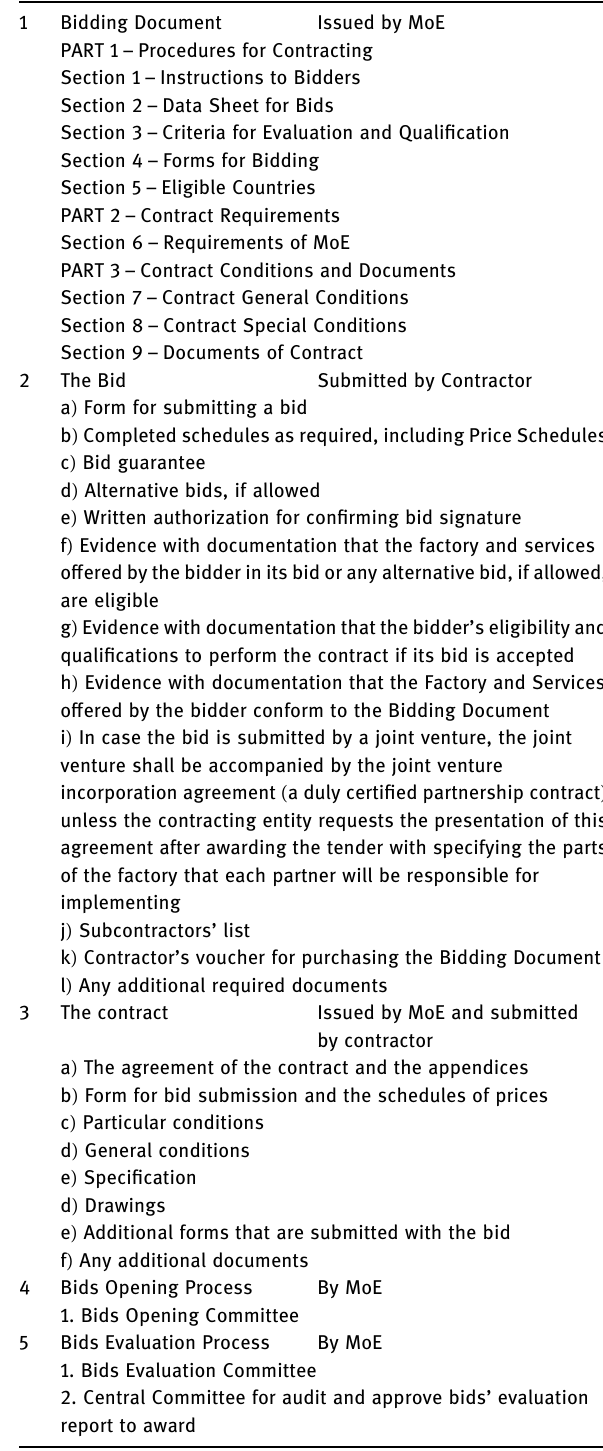
Table 1: MoE ’ s allocation budget Table 2: SSBD structure fl